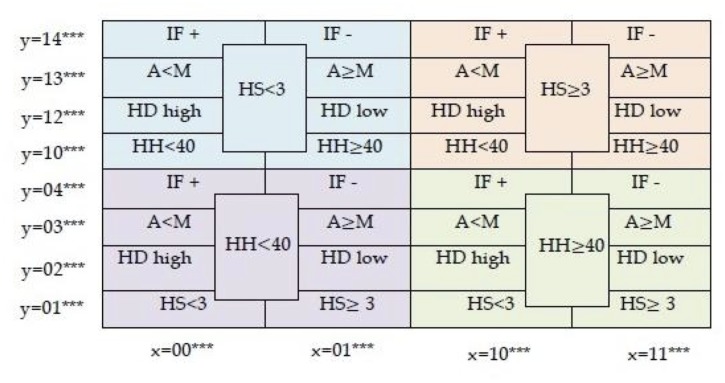
Regions in S
5 determined by the first and second significant variables.